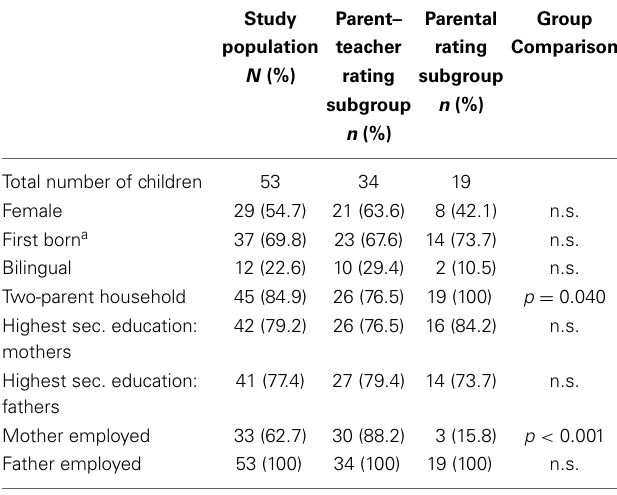
Table 1 | Demographic characteristics of the study